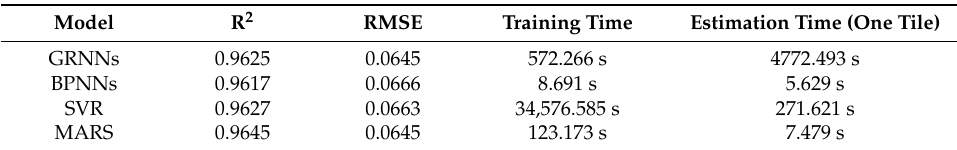
Table 2. The statistical performances of the four machine learning methods with 15,282 training samples.